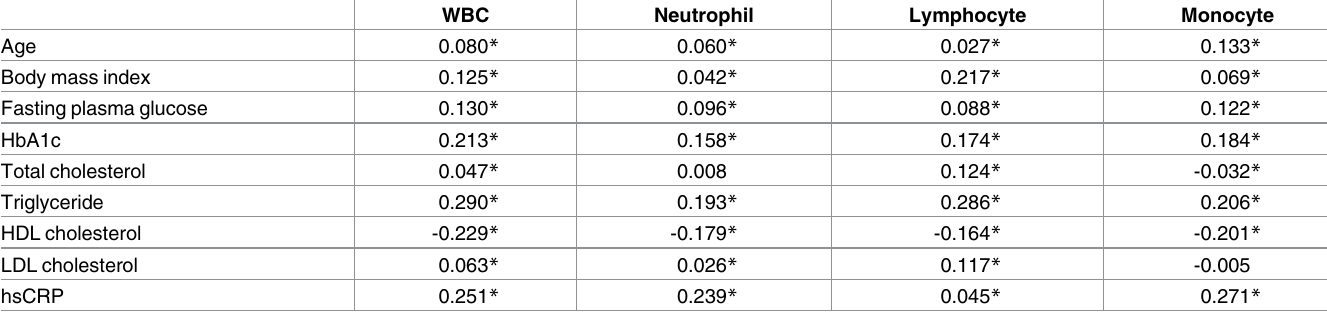
Table 2. Correlation between WBC subtypes and metabolic